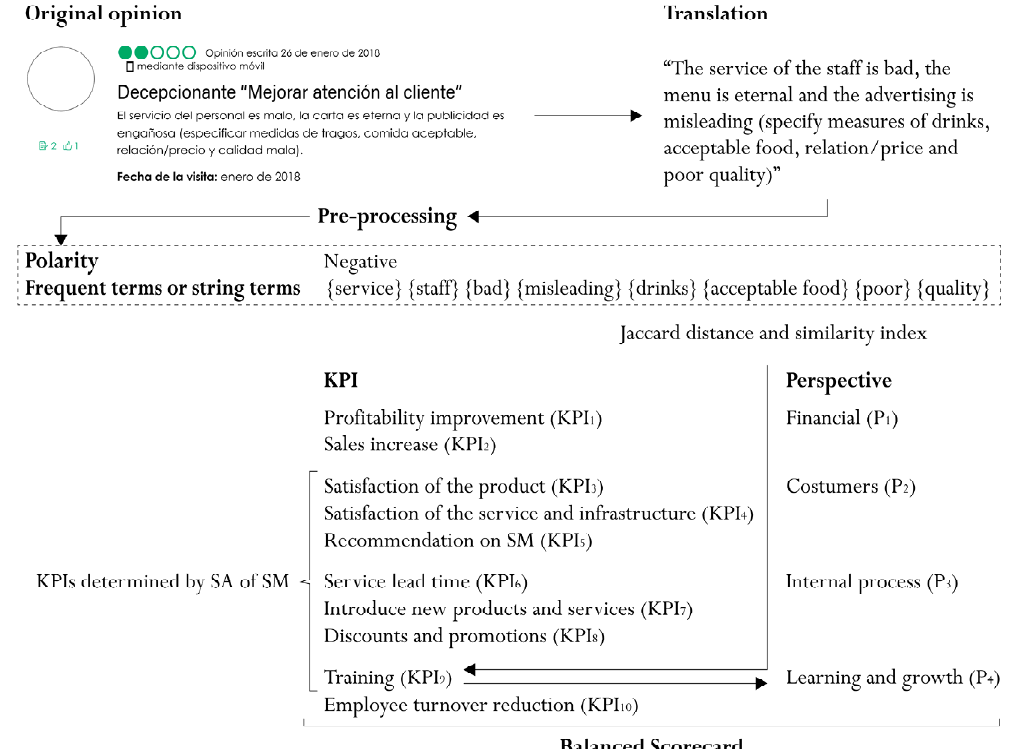
Figure 7. Representation of the automatic generation of the balanced scorecard. Table 4. Percentage of opinions categorized in the KPIs and perspectives.